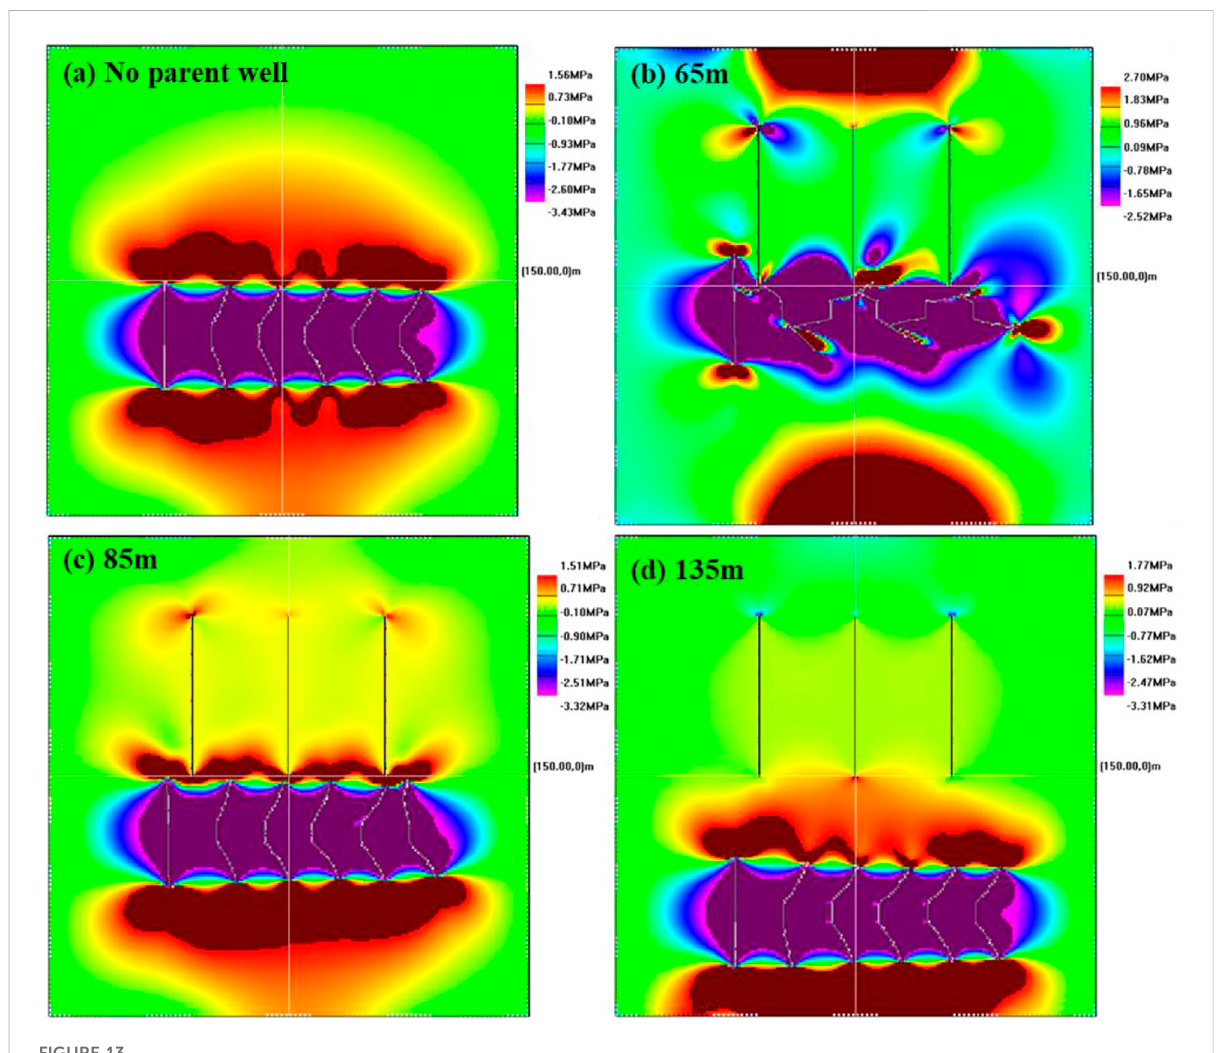
FIGURE 13 Normal stress distribution in the X-axis direction at different well